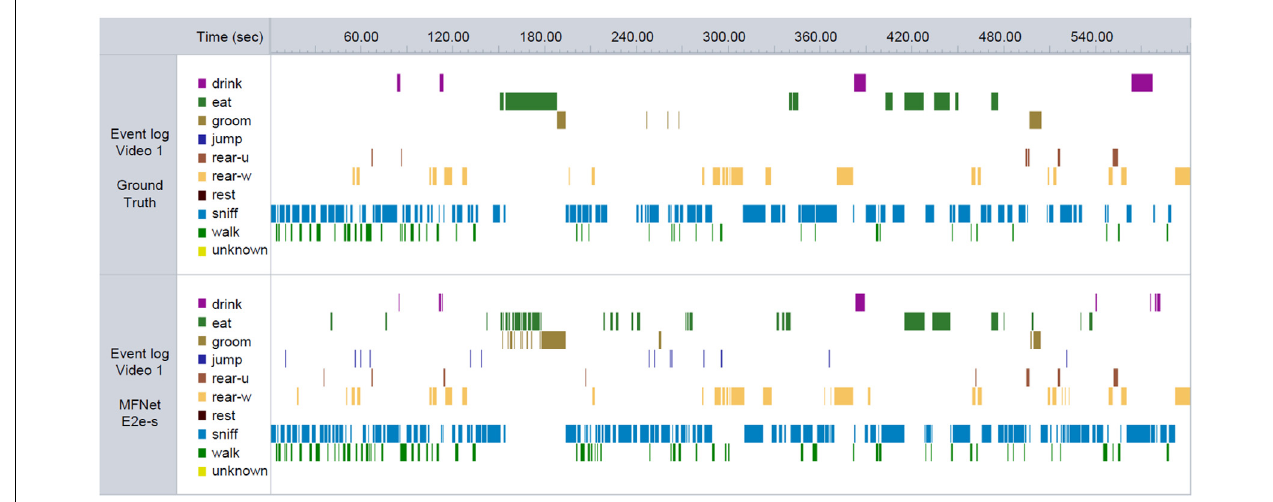
FIGURE 9 | Time plot of behavioral events coded by human observer (Ground truth; top) and scored by the Deep learning annotation system. Note the striking agreement between ground truth and automated annotations. The figure is redrawn from van Dam et al. (2020).